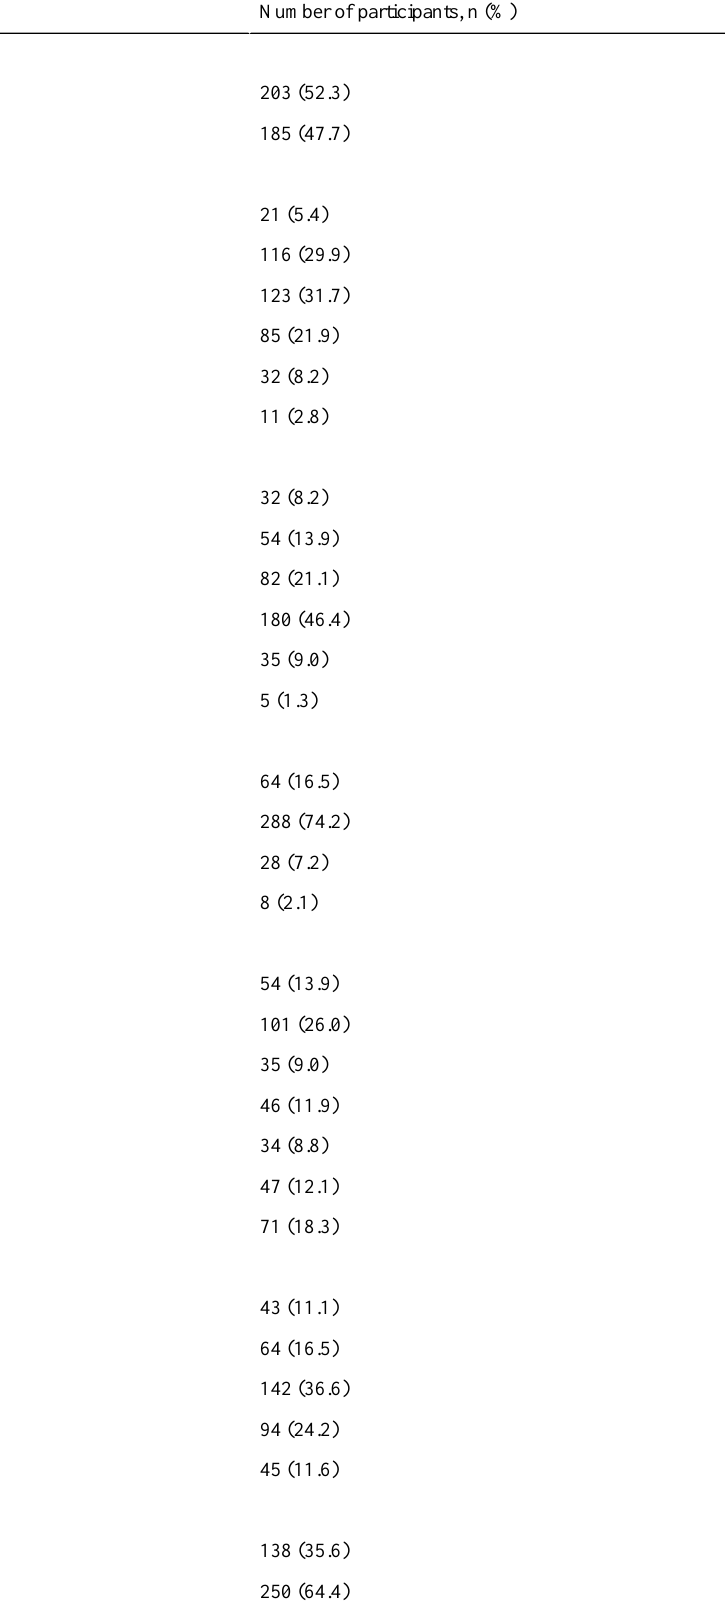
Table 1. Demographic characteristics of the participants